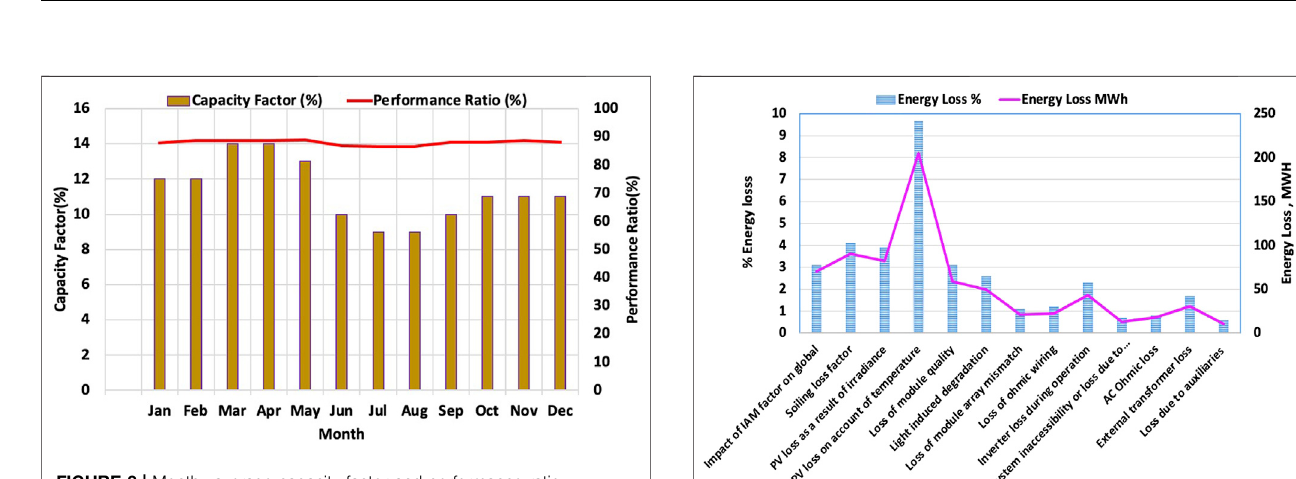
FIGURE 3 | Monthy average capacity factor and performance ratio.